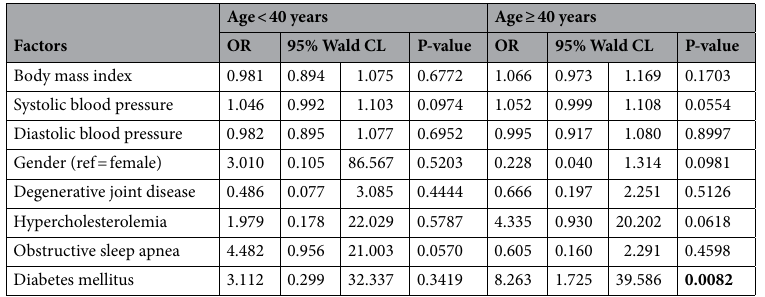
Table 5. Subgroup multivariate analysis. OR = Odds Ratio; C.I. = Confidence Interval.; Logistic Regression Analysis to obtain OR.